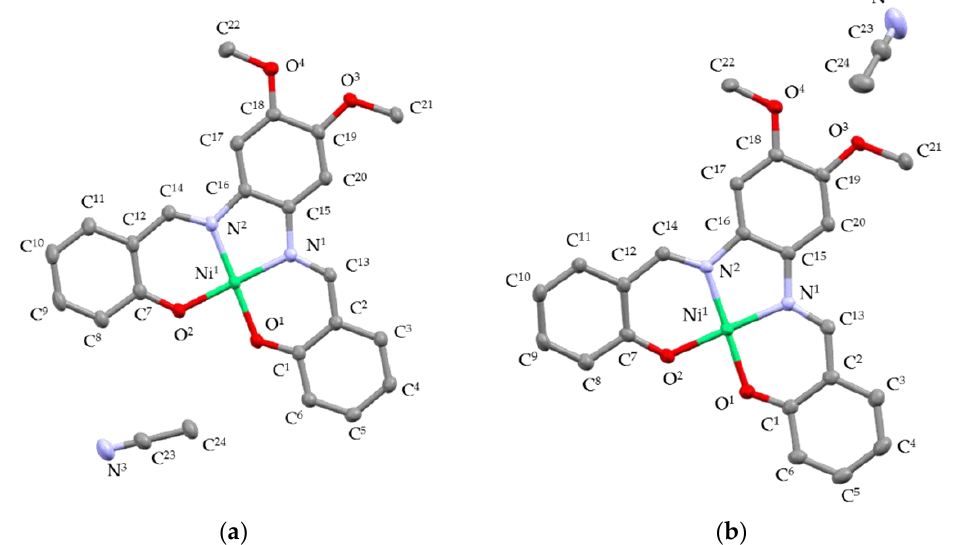
Figure 1. Molecular view of [Ni(Salphen(CH 3 O) 2 )]·CH 3 CN in representation of atoms with thermal ellipsoids ( p = 50%), structures ( a , b ).